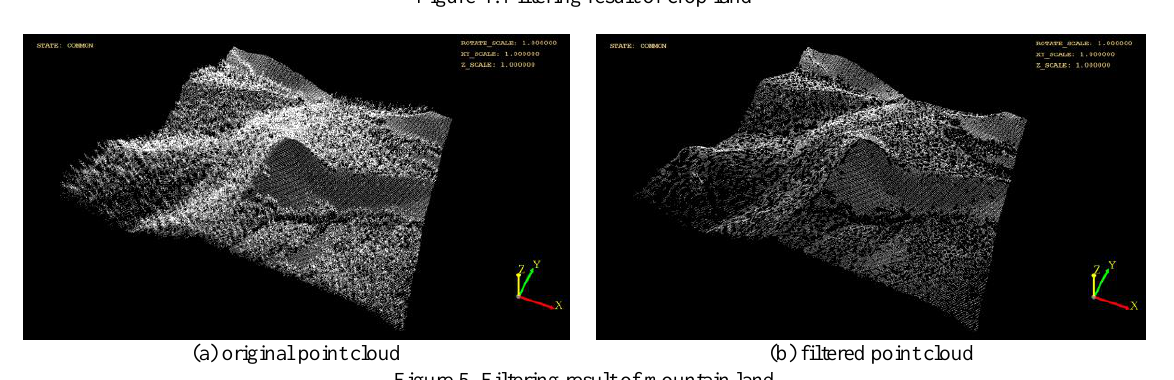
Figure 5. Filtering result of mountain land